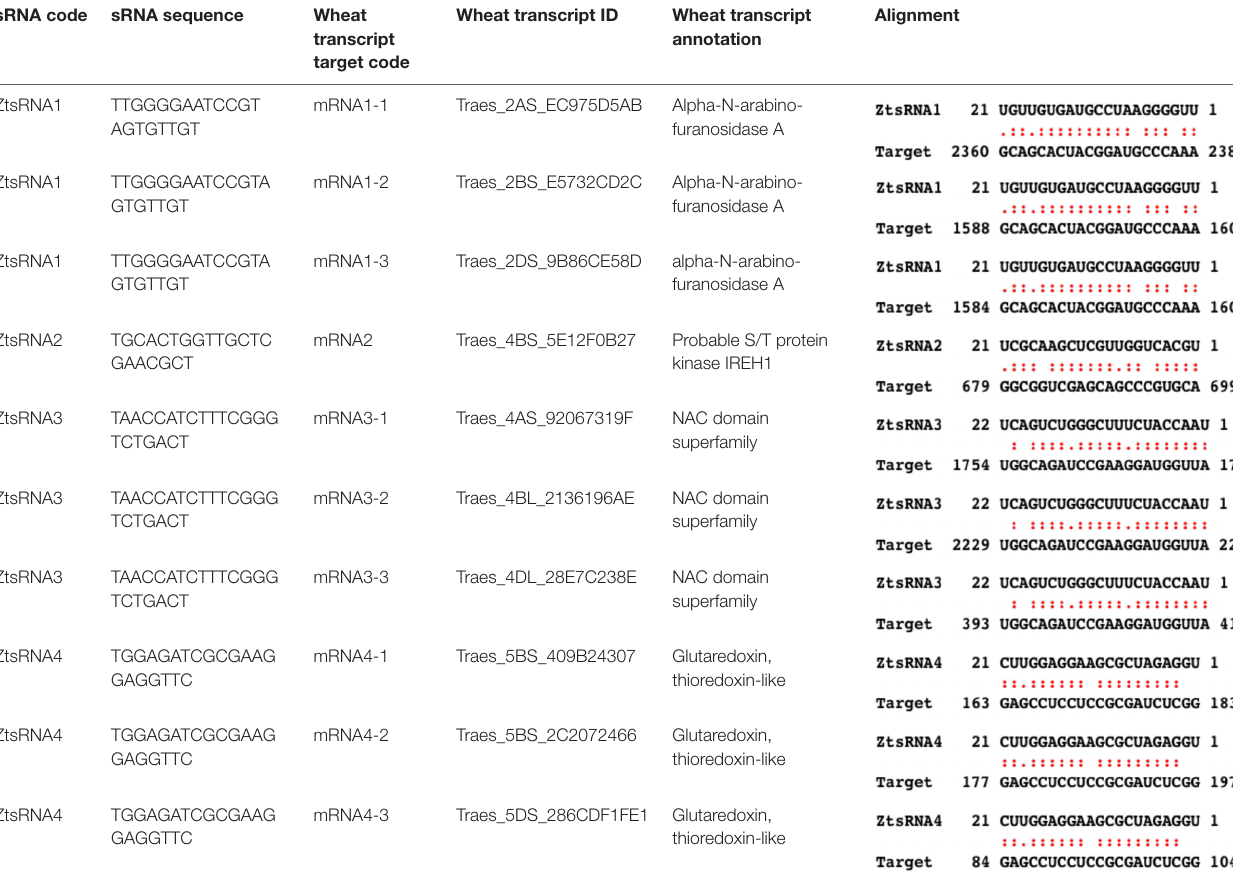
TABLE 1 | Zymoseptoria tritici IPO323 mature sRNAs selected for detailed study and their respective wheat mRNA targets. sRNA code sRNA sequence Wheat transcript target code